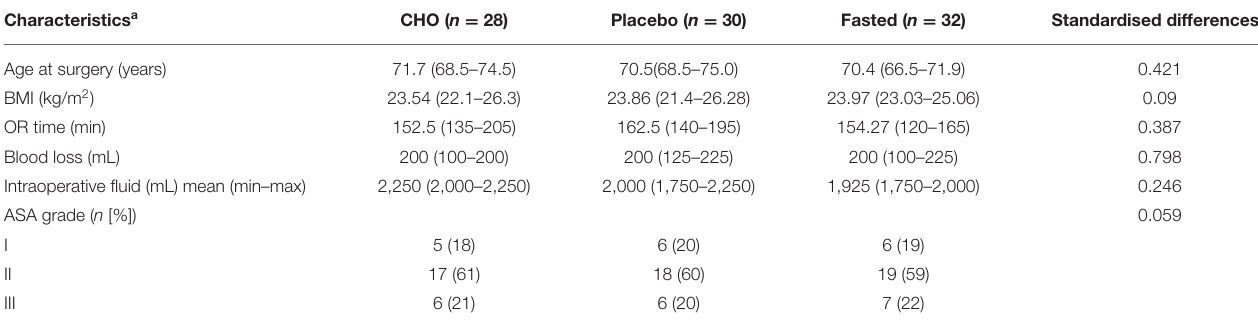
TABLE 1 | Patient demographics and surgical characteristics. Characteristics